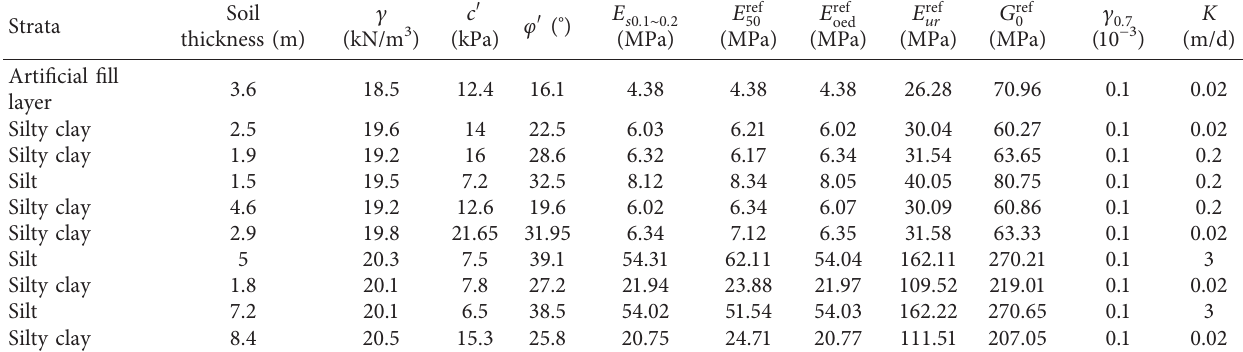
Table 4: Physicomechanical parameters of the soils in the